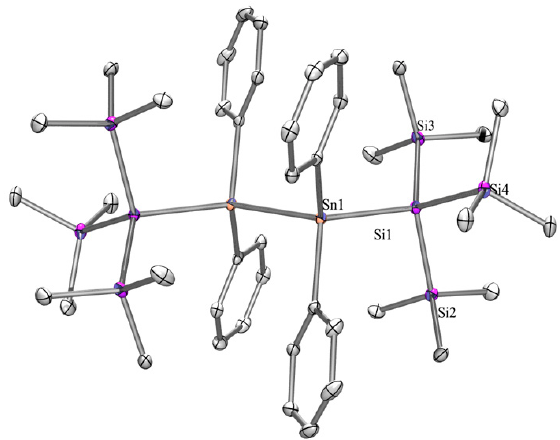
Figure 3. Molecular structure of 6 (thermal ellipsoid plot drawn at the 30% probability level). Non-labeled atoms are generated by symmetry operations. All hydrogen atoms are not shown for clarity (bond lengths in Å, angles in °). Si(1)–Si(2) 2.3476(8), Si(1)–Sn(1) 2.5988(6), Si(2)–C(14) 1.8682(19), Sn(1)–C(1) 2.1603(16), Sn(1)–Sn(1A) 2.8217(7), Si(1)–Sn(1)–Sn(1A) 119.939(12).